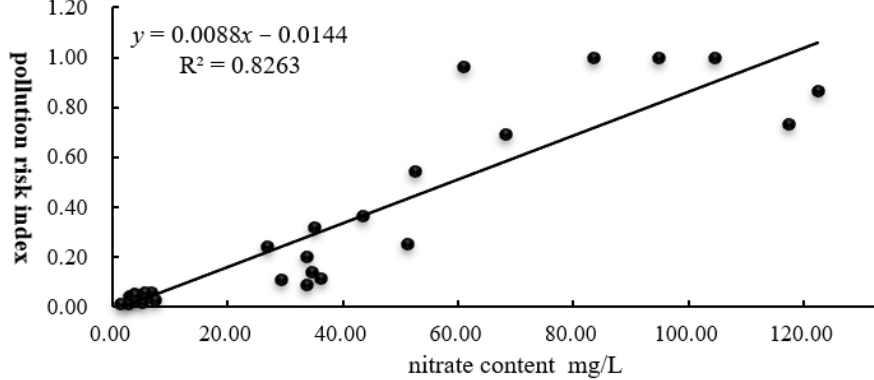
Figure 5. Correlation diagram between nitrate content and pollution risk